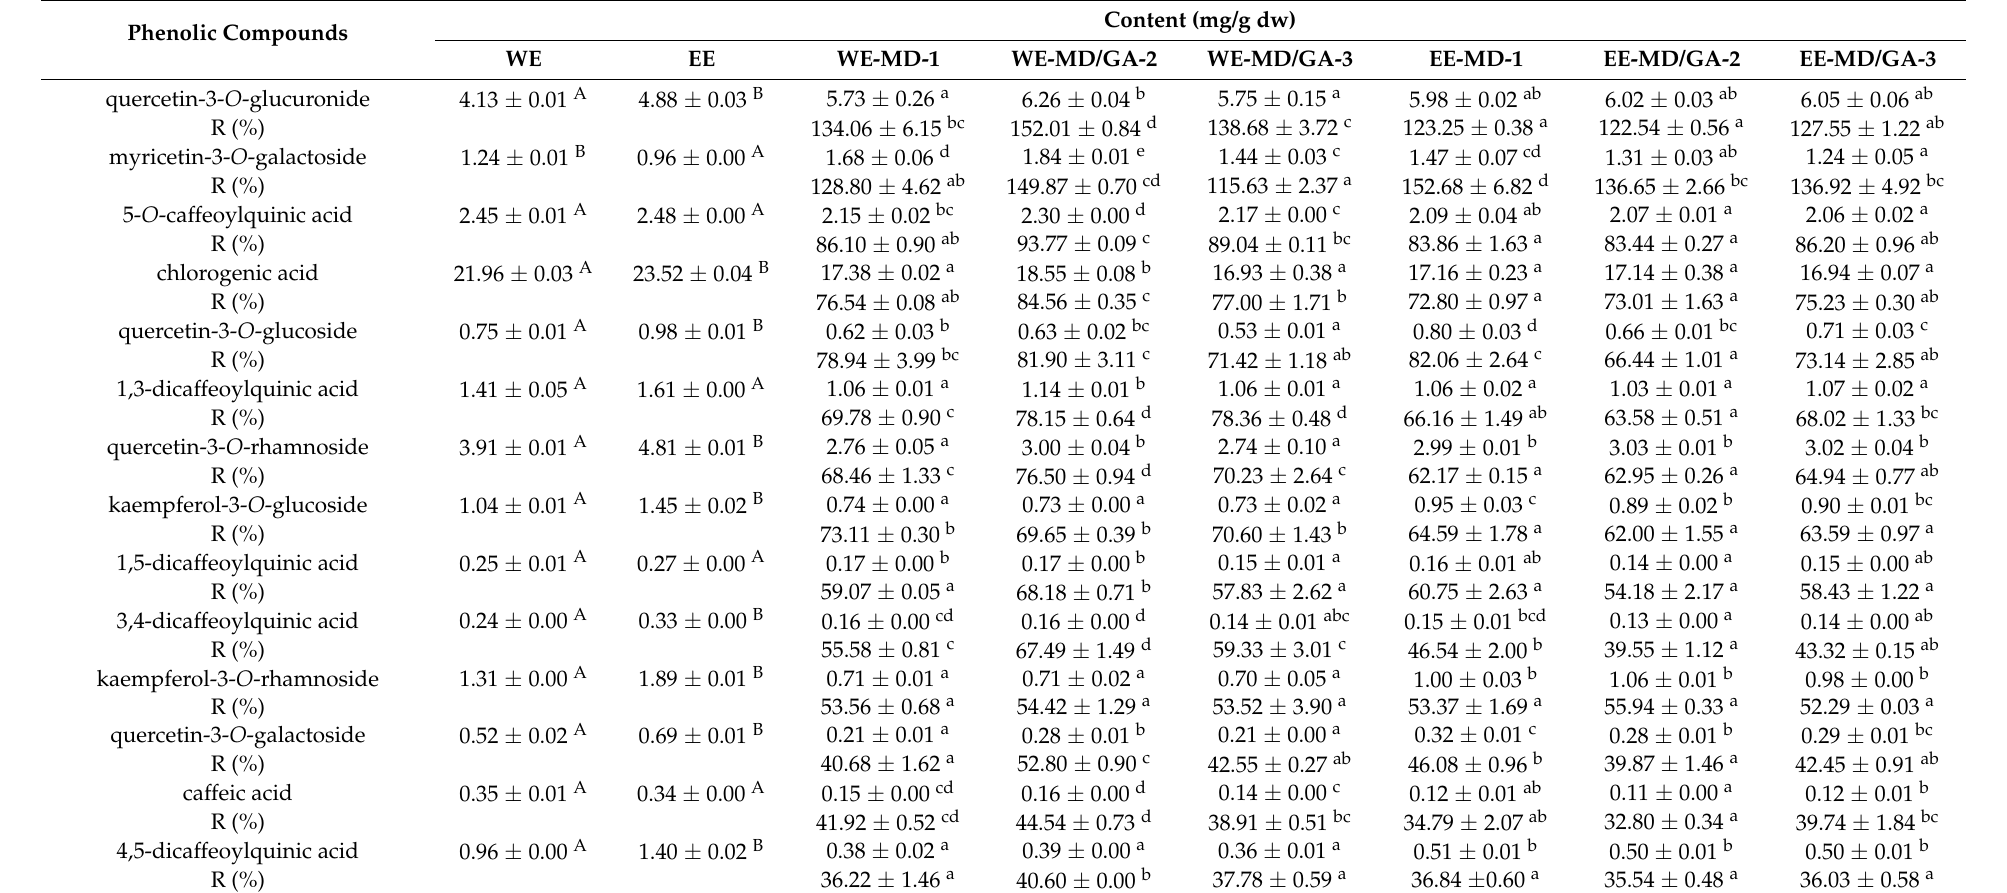
Table 4. The content of major phenolic compounds in powders and their retentions after spray